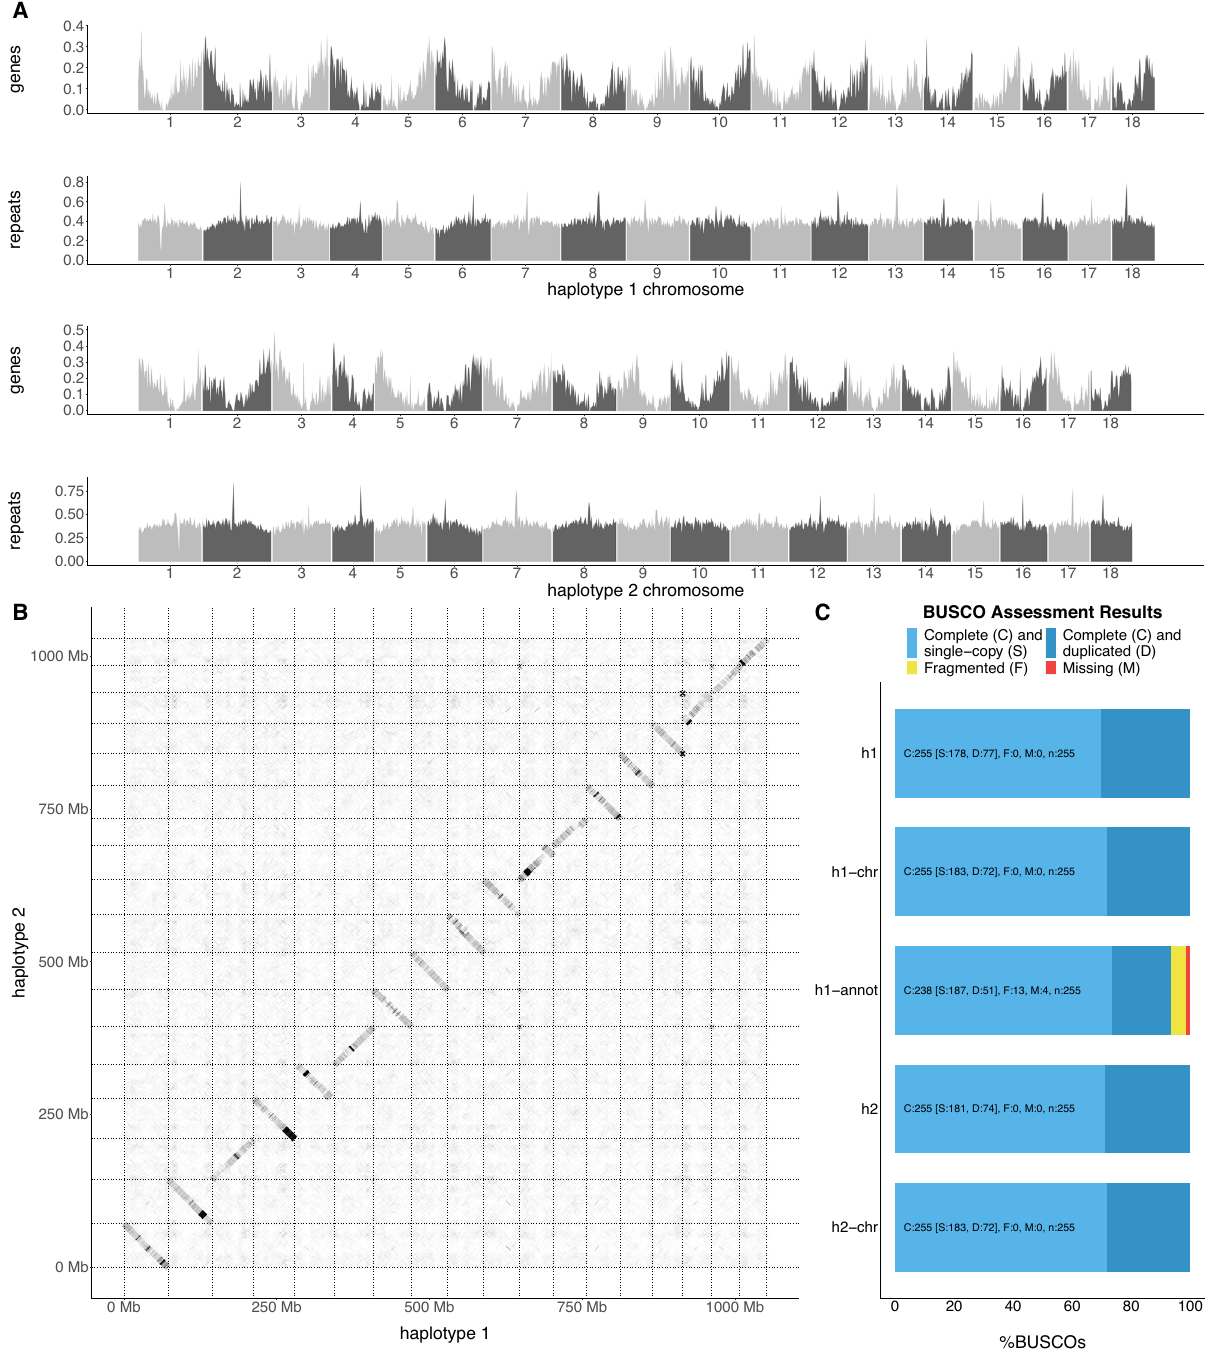
haplotypeassembly(h1;h2),eachchromosome-onlyassembly(h1-chr;h2-chr),and the gene annotations for haplotype 1 (h1-annot) using the eukaryota odb10 gene set. Source data are provided as a Source data fi